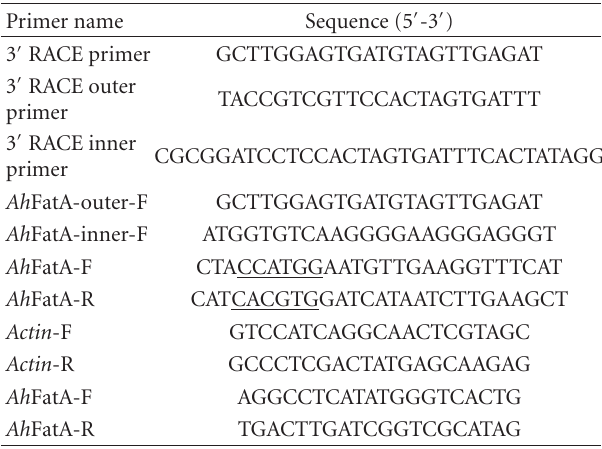
Table 1: Primer sequences used in this